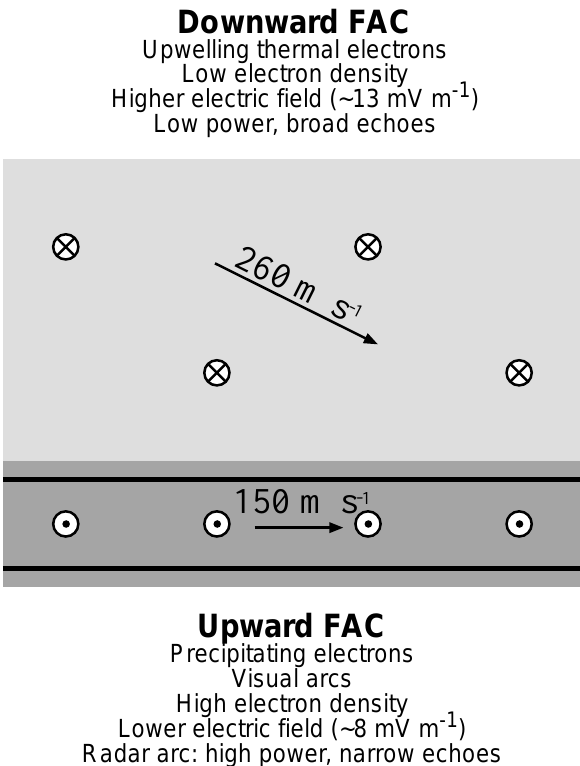
Fig. 10. A schematic showing our suggestion of the FAC system associated with the radar backscatter and visual arcs. The radar arc and visual arcs are confined to a region of upward FAC (dark grey region), adjacent to a broader region of downward FAC lying to the north (light grey region). Also indicated is the approximate electron drift vector within the two regions, deduced from the beam- swinging